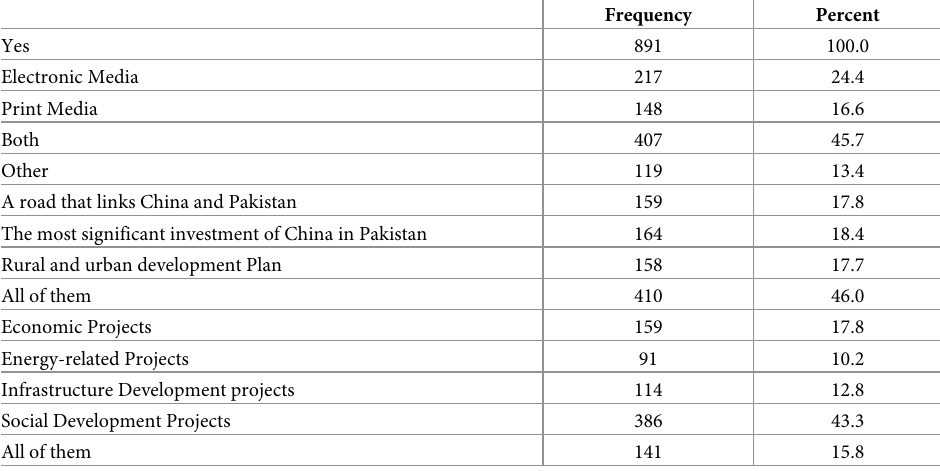
Table 2. Respondents’ knowledge about the CPEC